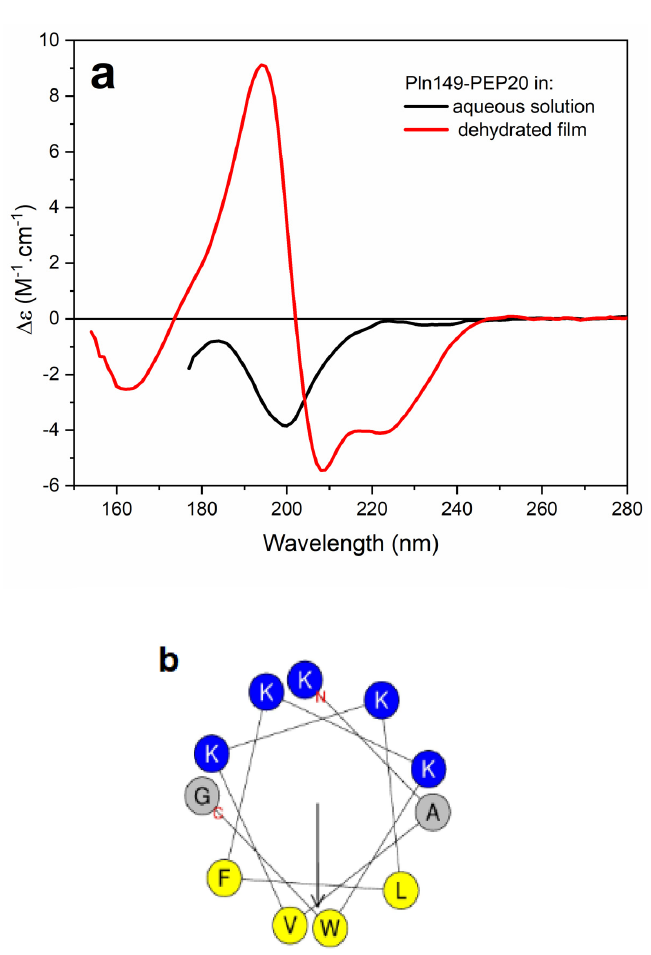
Figure A1. ( a ) SRCD spectra of Pln149-PEP20 in sodium phosphate buffer pH7 (black) and in the semidehydrated film on the surface of a quartz − Suprasil plate (red). ( b ) Helical wheel projection of the Pln149-PEP20 sequence. Nonpolar residues are labelled in yellow, positively charged residues are in blue.